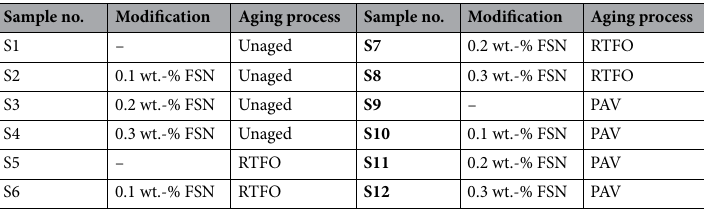
Table 2. Samples with different additives and aging processes.